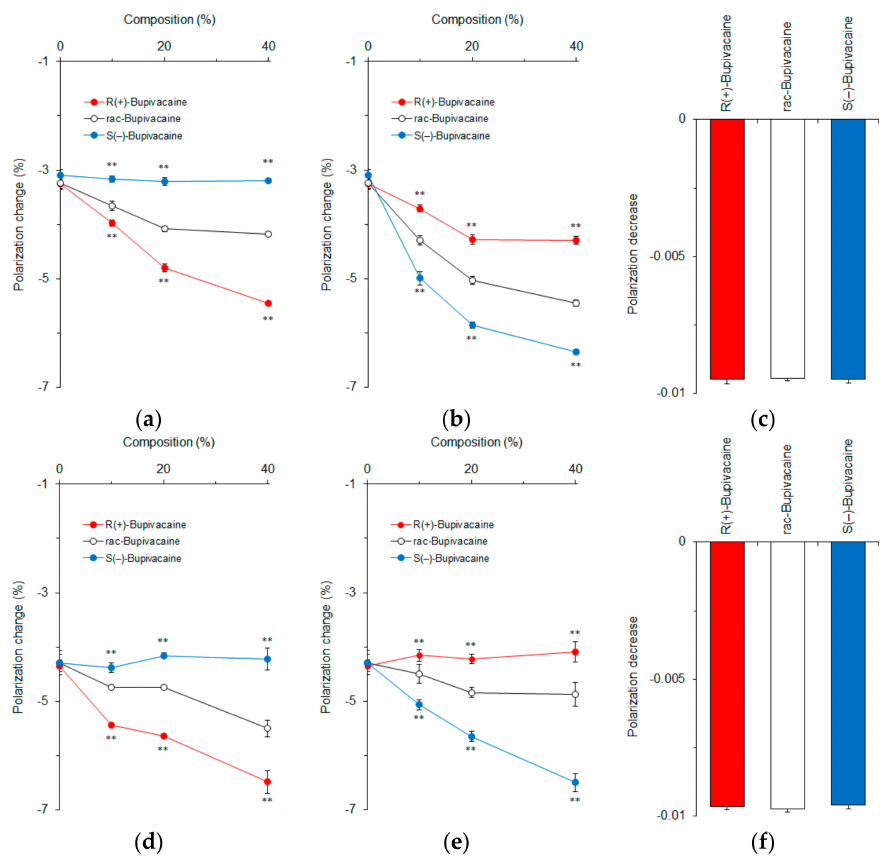
Figure 4. Effects of 0–40 mol % cholesterol ( a ); 0–40 mol % epicholesterol ( b ); 20 mol % cholesterol and 20 mol % epicholesterol ( c ); 0–40 mol % 5 α -cholestan-3 β -ol ( d ); 0–40 mol % 5 β -cholestan-3 α -ol ( e ); and 20 mol % 5 α -cholestan-3 β -ol and 20 mol % 5 β -cholestan-3 α -ol ( f ) on interactions of bupivacaine stereoisomers (50 µ M for each) with cardiomyocyte-mimetic membranes. ** p <0.01 compared with rac